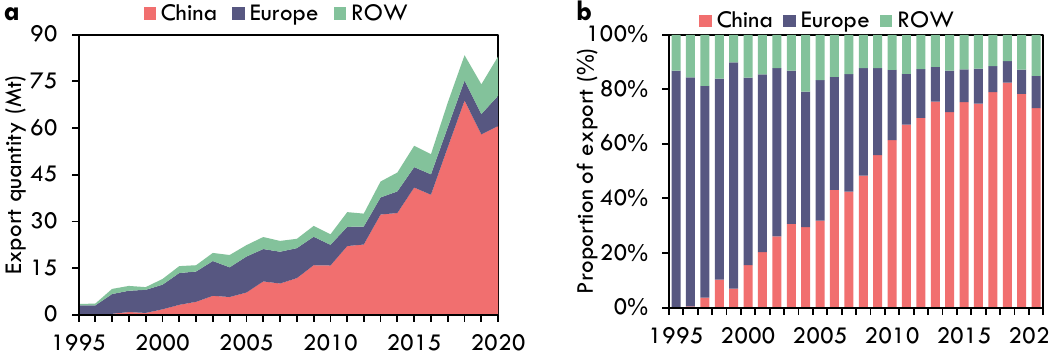
Figure 2. Brazil’s soybean exports, 1995–2020 . ( a ) Changes in Brazil’s soybean export quantity to different destinations. ( b ) Changes in Brazil’s soybean export structure to different destinations. Source: Based on data from [9].